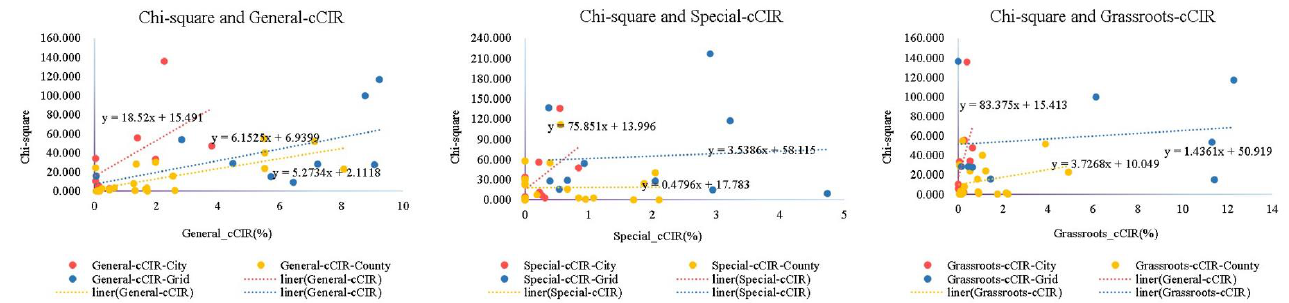
Figure 9. Infection rate and chi-square trend chart of different hospitals.